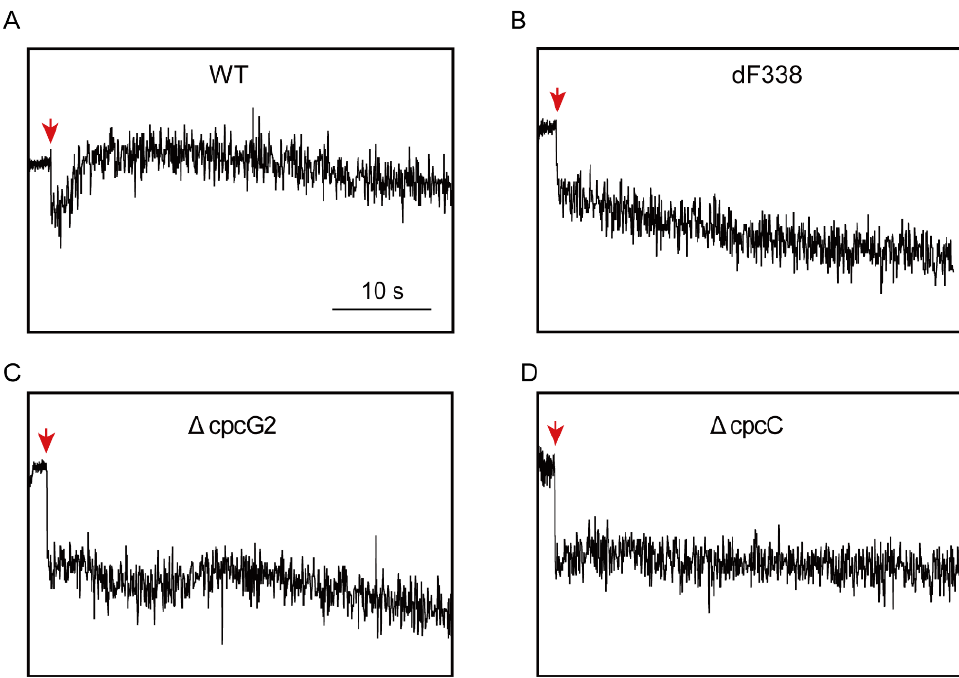
Figure 4. Post-illumination rise of Chl fluorescence (PIRF) analysis. PIRF analysis of the wild-type (WT) ( A ), dF338 ( B ), ΔcpcG2 ( C ) and ΔcpcC ( D ). Cells were illuminated with an actinic light for 30 s before the actinic light was turned off (downward arrows) and the transient increase of Chl fluorescence at the wavelength of 685 nm was monitored. Bar indicates 10 s.